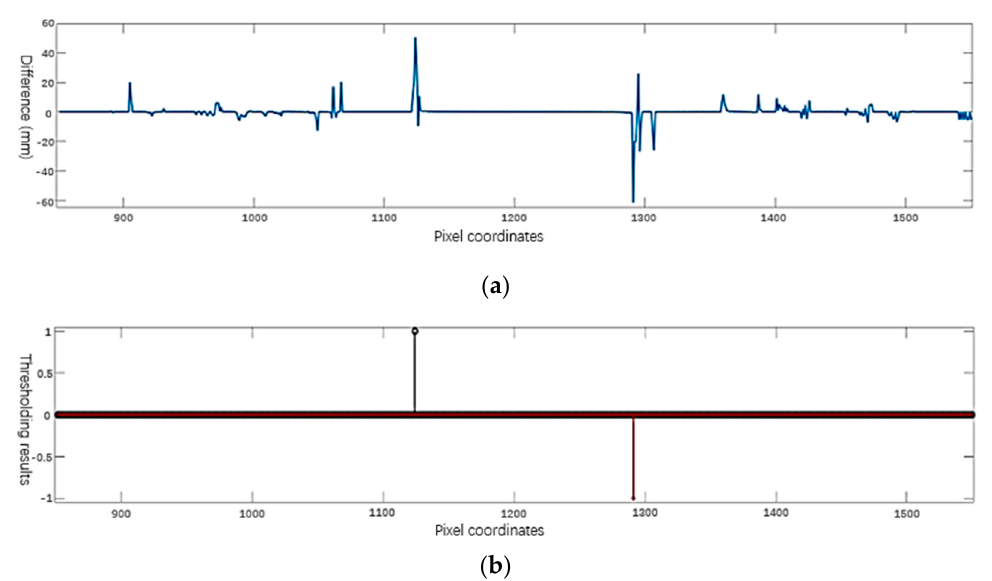
Figure 8. Locate the rail position: ( a ) Derivation f'(x) from f(x) (or discrete first order difference); ( b ) g (x) is obtained by thresholding.